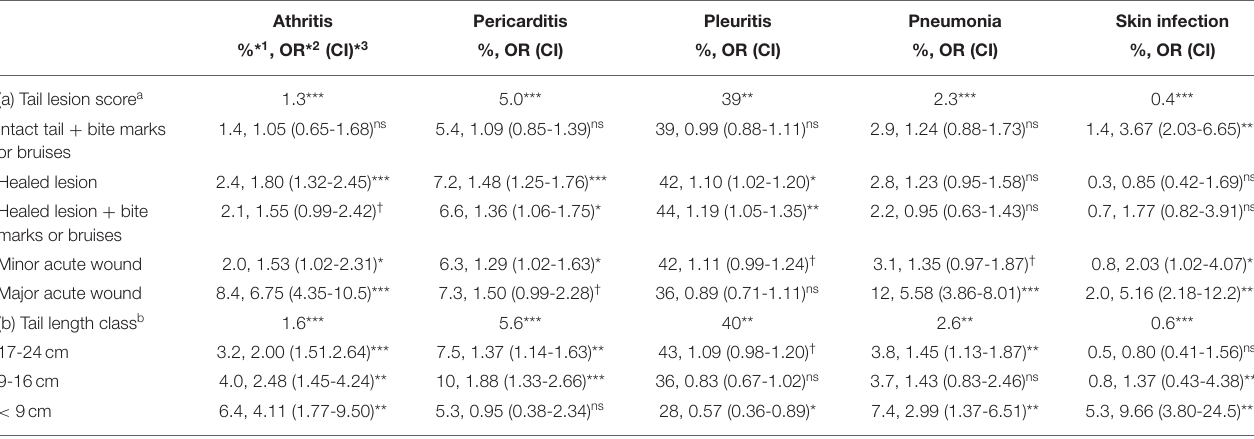
TABLE 4B | Results from logistic regressions on the association between (a) tail lesion score and (b) tail length class (separate models) and arthritis, pericarditis, pleuritis, pneumonia, and skin infection recorded at meat inspection ( n = 14 382). Athritis Pericarditis Pleuritis Pneumonia